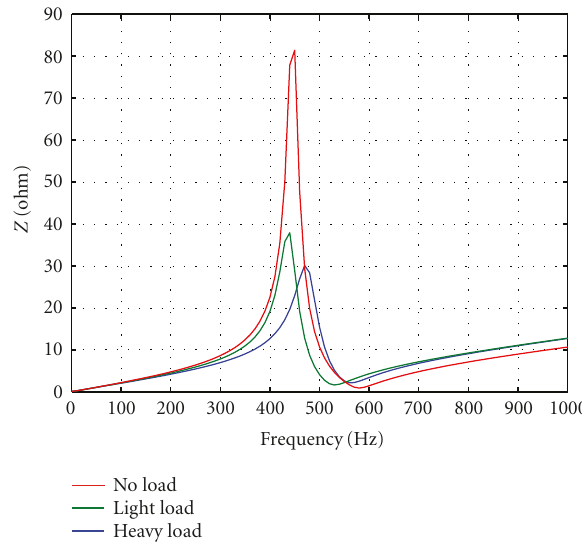
Figure 5: System impedance scan results of a typical 12.47 kV sys- tem for two di ff erent loading